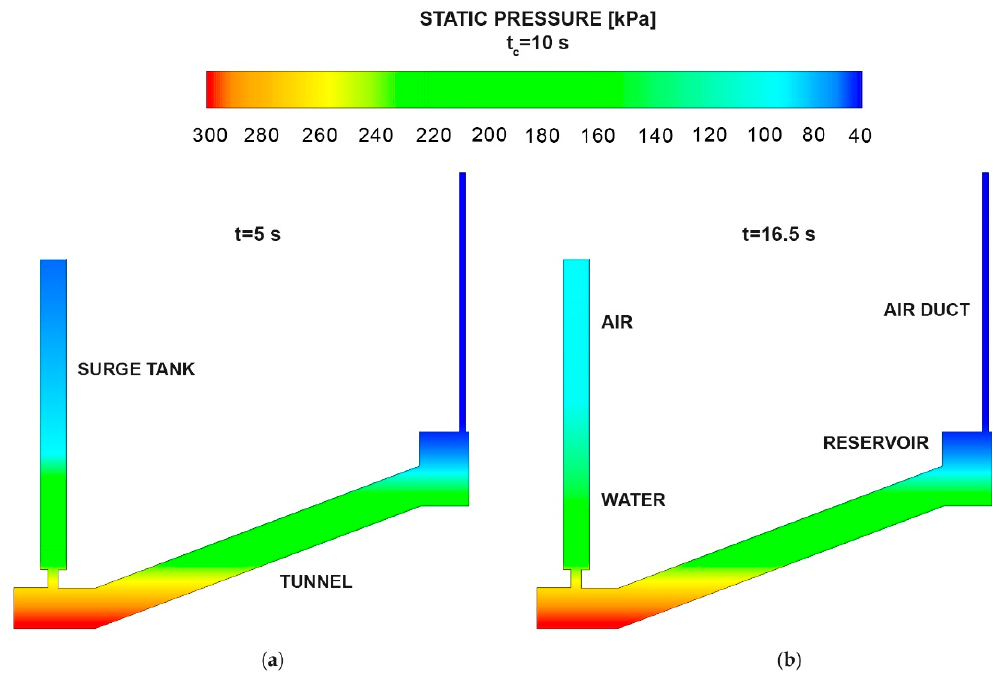
Figure 11. Static pressure variation in the longitudinal section of the model for t c =10 s. ( a ) At time t=5 s beginning of the closing process; and, ( b ) At time t =16.5 s (maximum pressure).